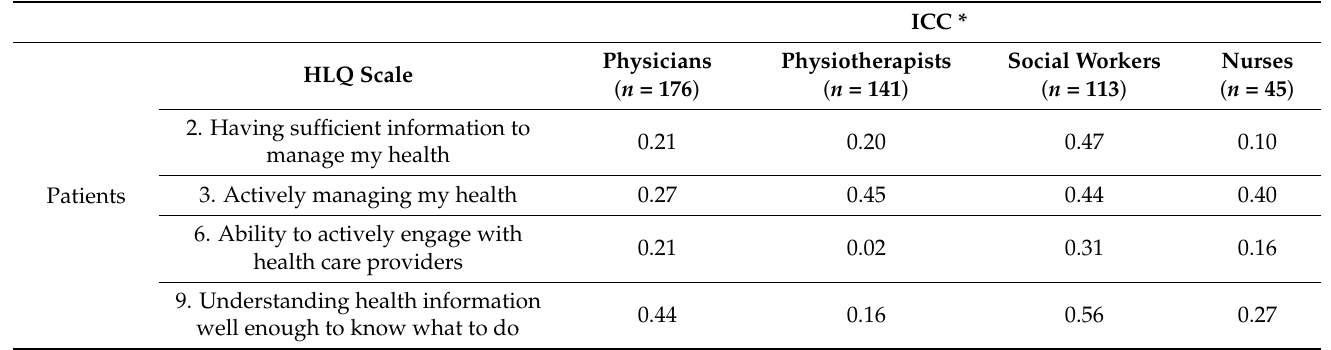
Table 3. Intraclass coefficient (ICC) of HCPs’ and patients’ estimation of patients’